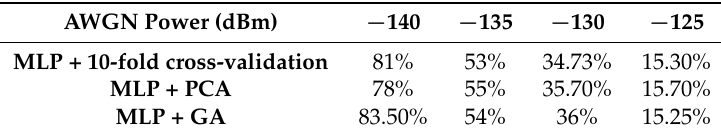
Table 10. ML-based prediction results for AMC1.